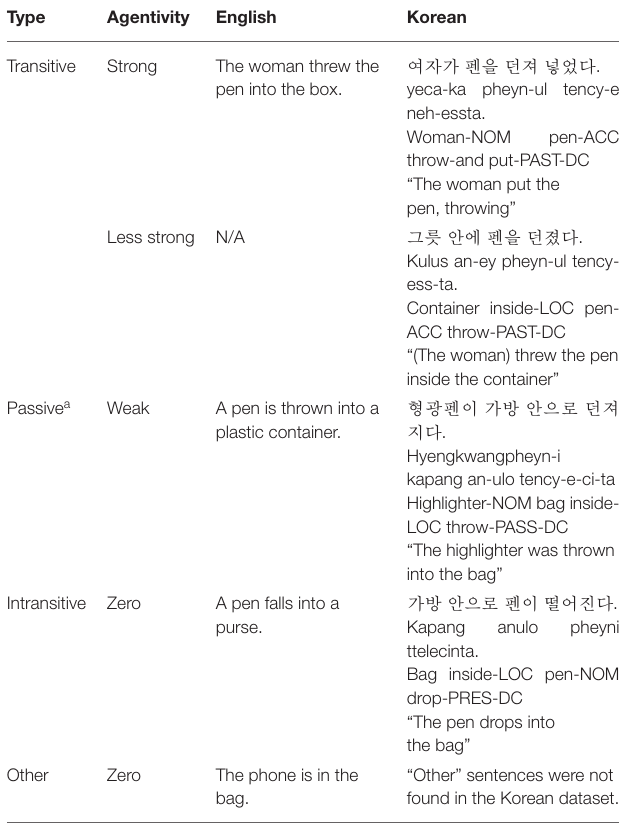
TABLE 1 | Event stimuli. TABLE 2 | Example descriptions extracted from English and Korean